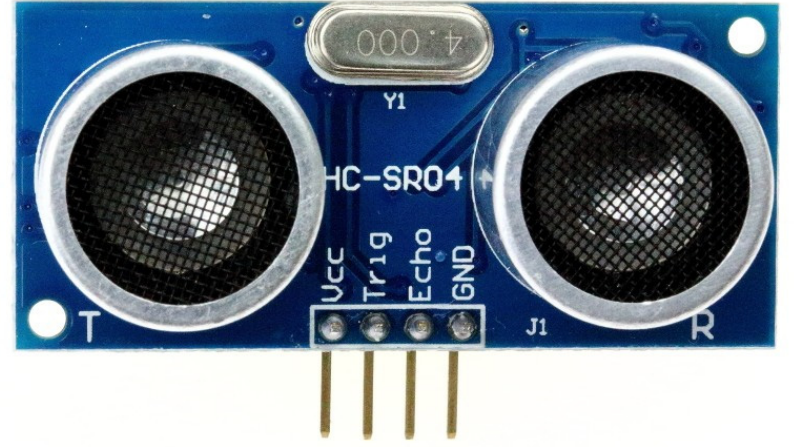
Figure 3. Ultrasonic sensor.